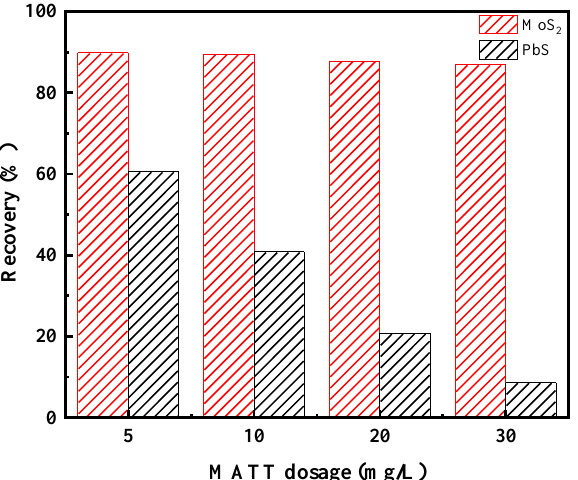
Figure 5. The flotation separation results of artificially mixed minerals (diesel dosage 30 mg/L, MIBC 20 mg/L, pH = 9).